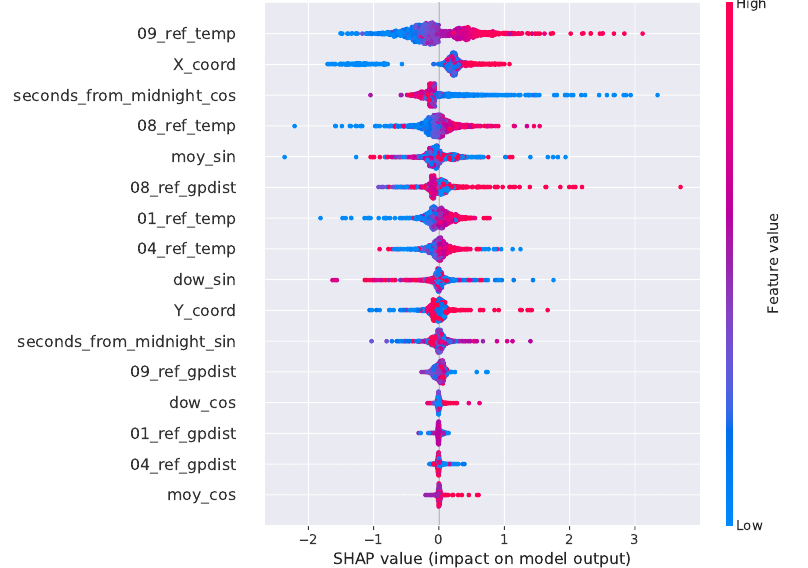
Figure 12. SHAP values of the attributes considered in the second step of the feature selection